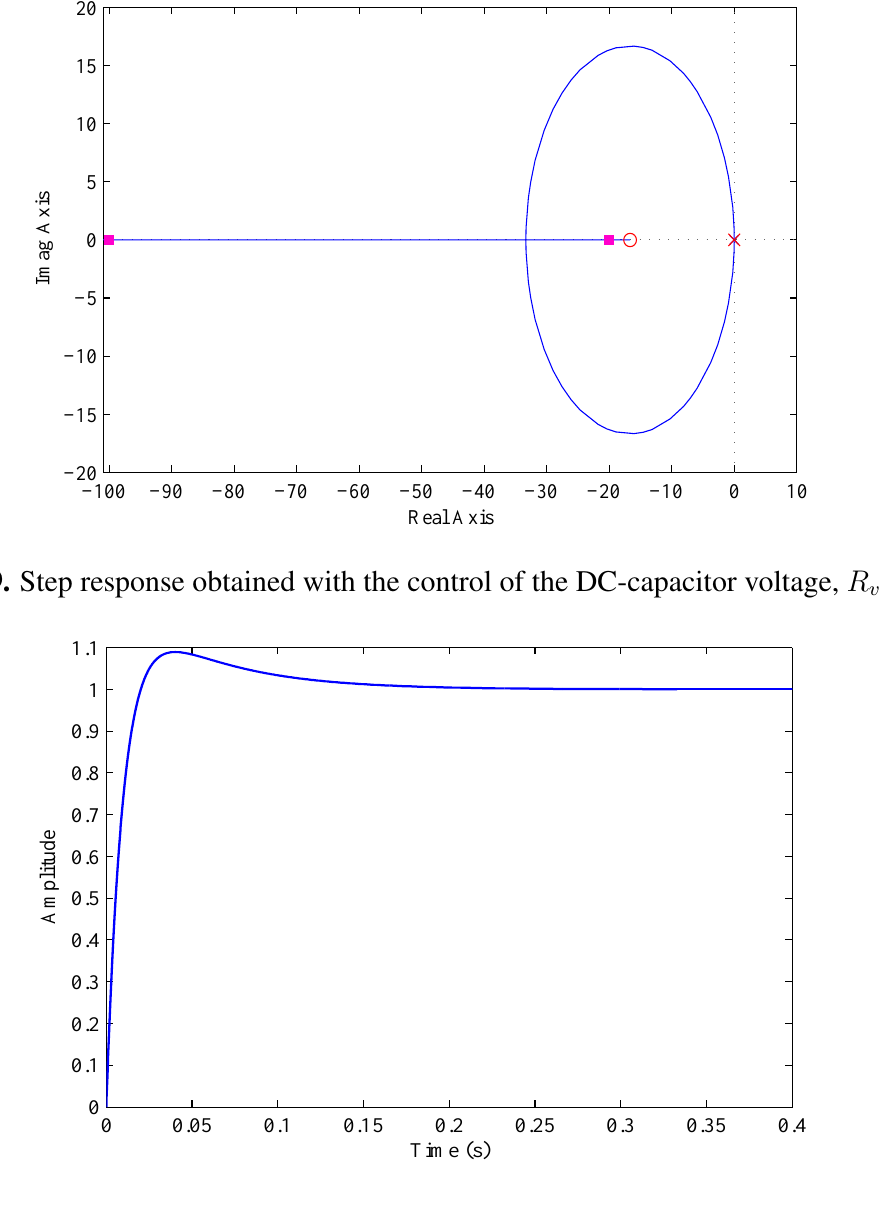
Figure 8. Root locus for the control of the DC-capacitor voltage, R v